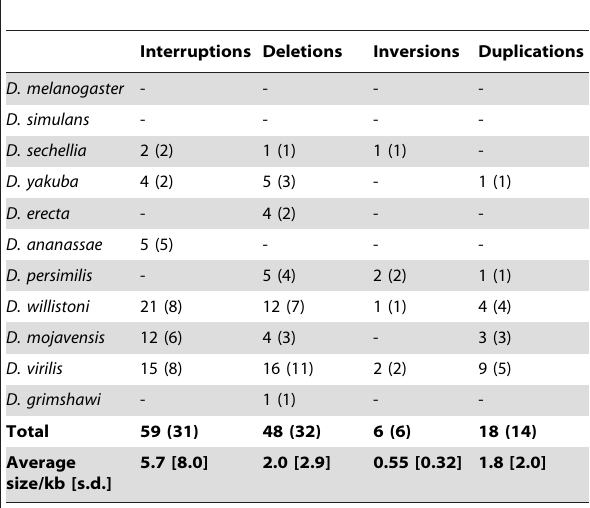
Table 2. Number of gross rearrangement events for each Drosophila species.